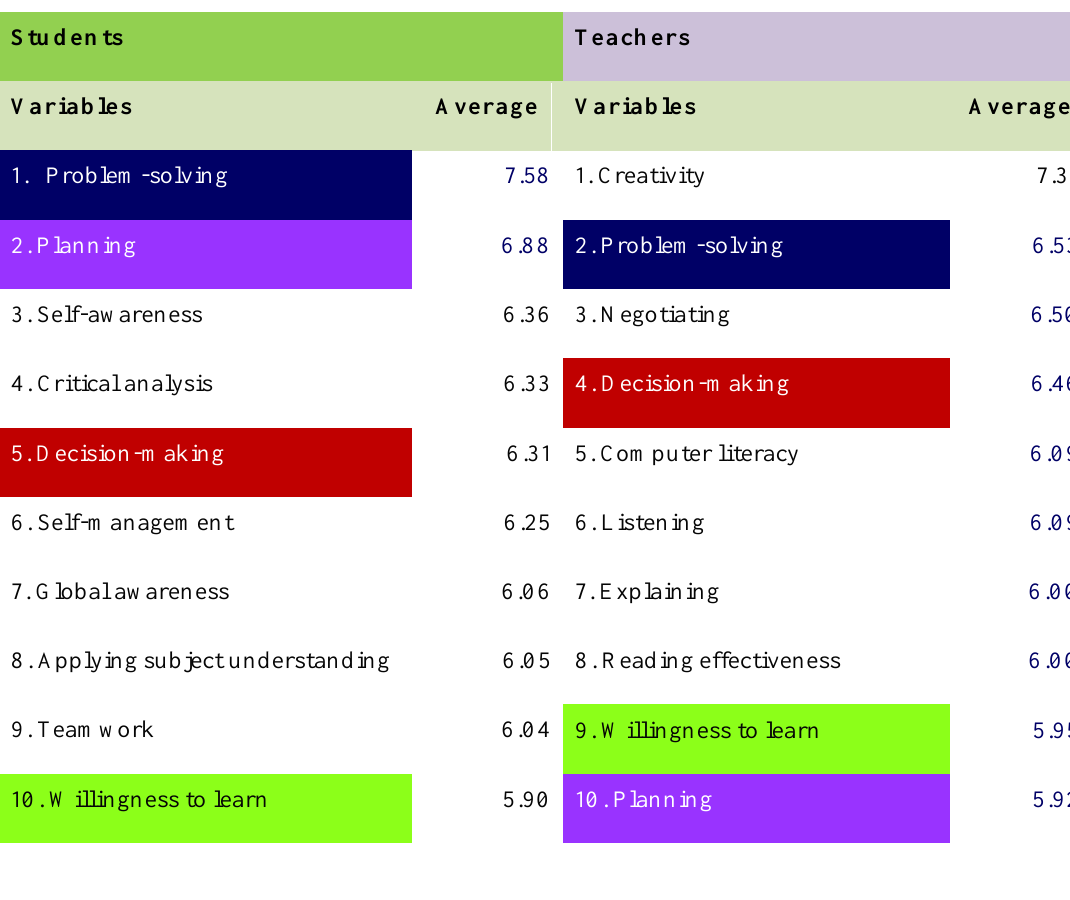
The Four Common